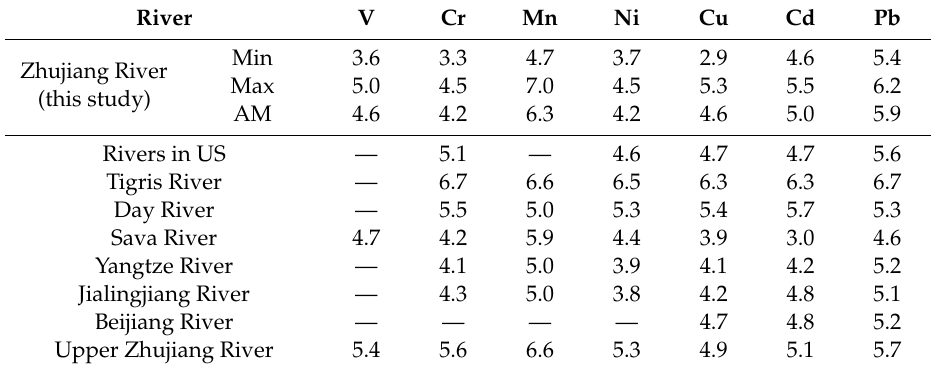
Table 5. The partition coe ffi cients (lgK d ) of heavy metals in the Zhujiang River and global rivers.